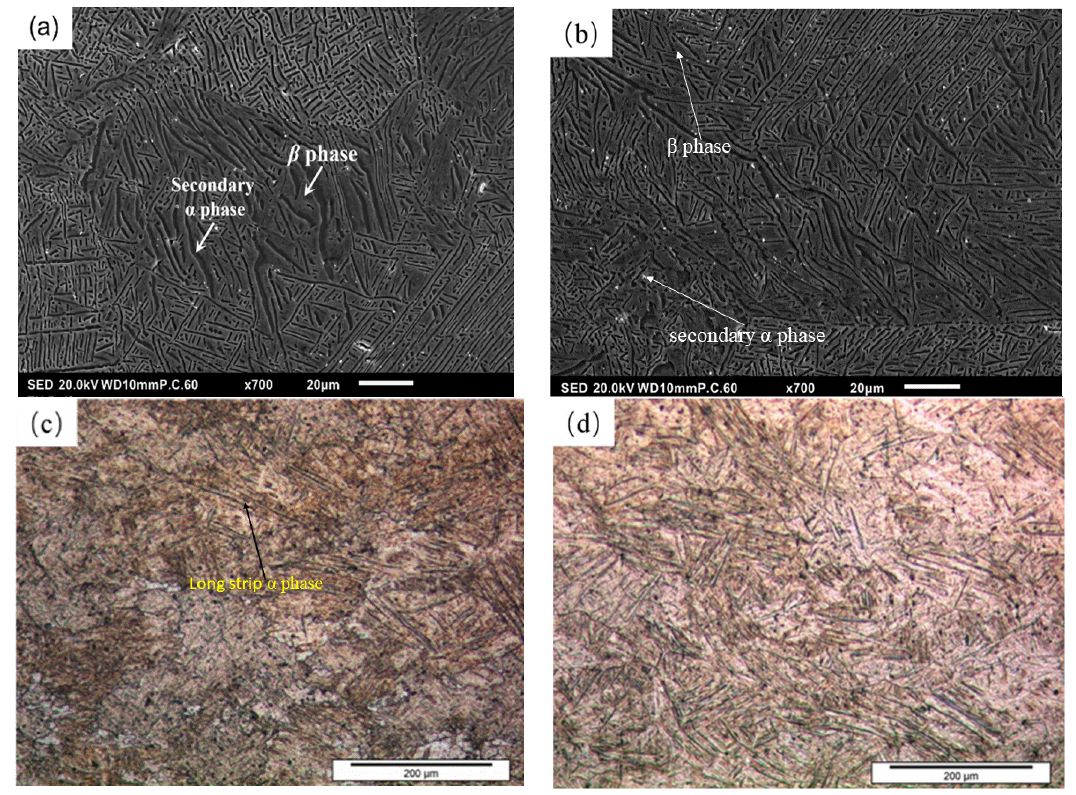
Figure 11. High-temperature compression microstructure of Ti–10V–1Fe–3Al alloy at strain rate of 0.01s −1 : ( a ) 730, ( b ) 790, ( c ) 820, and ( d ) 880 °C .